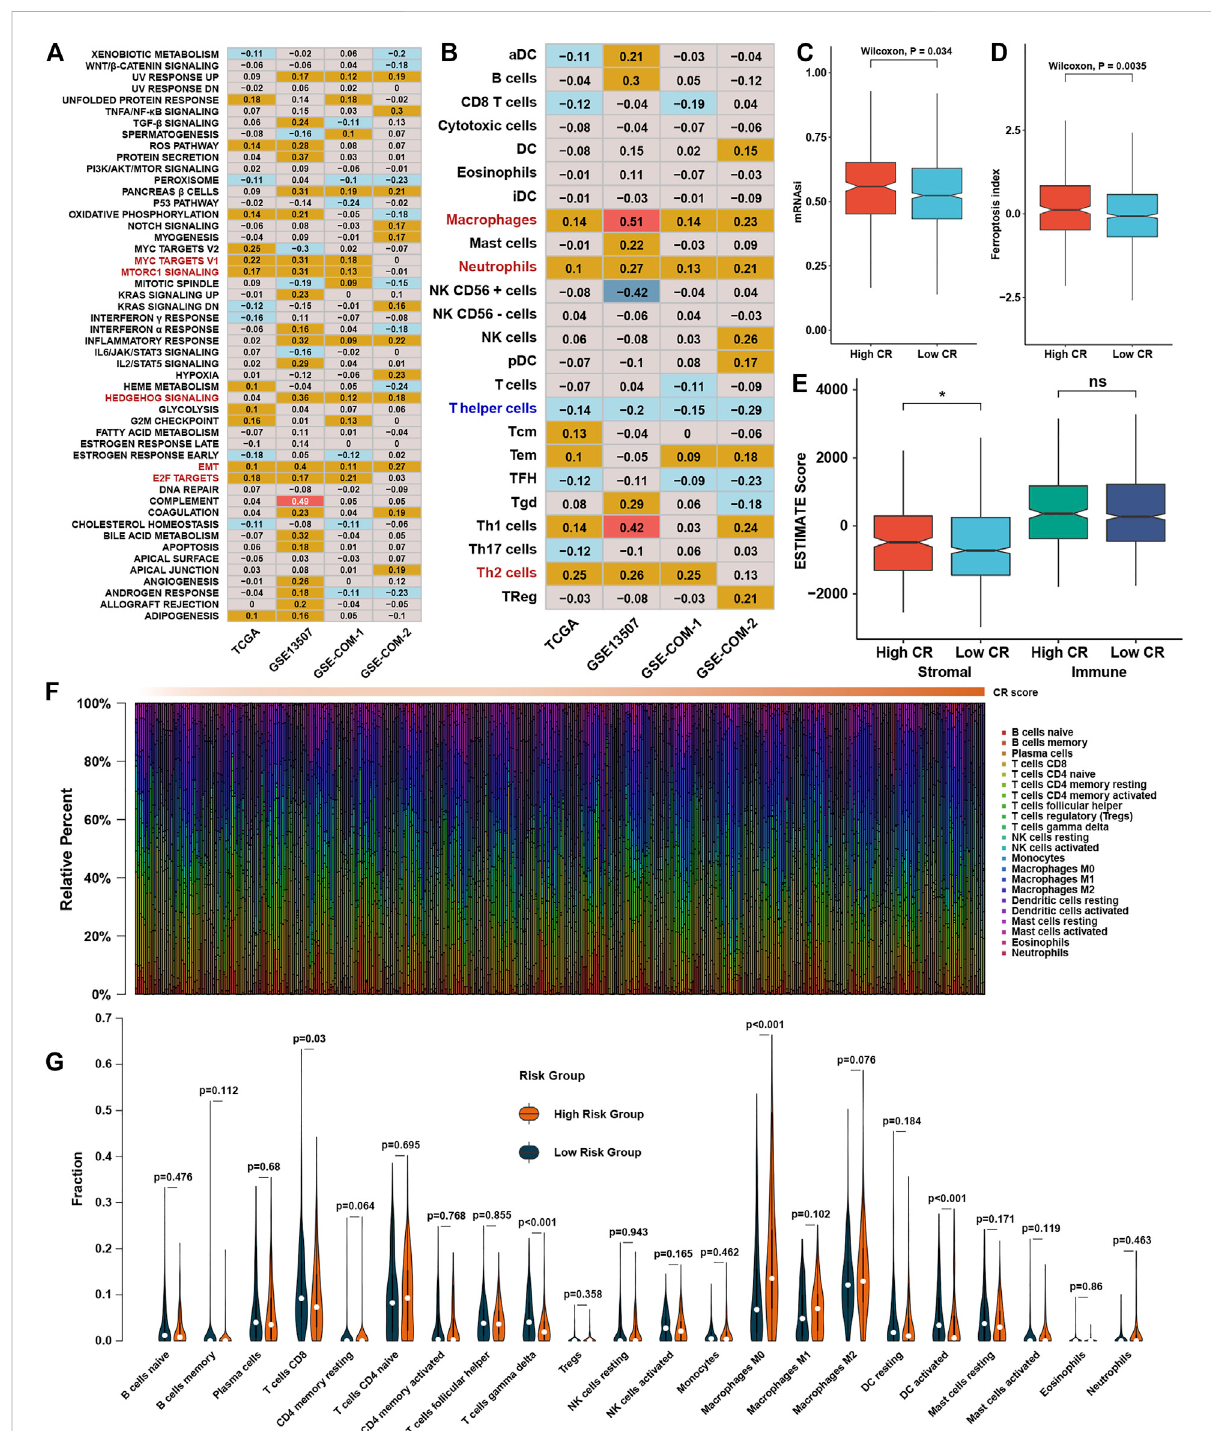
FIGURE 7 Functional characteristics of CR scores in BLCA (A) . Correlation analysis between CR scores and GSVA scores. The number represents the correlation coef fi cient of the two objects at the intersection (B) . Correlation analysis between CR scores and in fi ltration levels of immune cells (C) . The abundance of mRNAsi in different CR score groups (D) . The abundance of FPI in different CR score groups (E) . The abundance of ESTIMATE scoresindifferentCRscoregroups (F) .Thedistributionof22immunecellscalculatedbyCIBERSORTwithchangeofCRscores,differentcolors represent different immune cell types (G) . Violin plot of the relative in fi ltration level of immune cells between different CR score